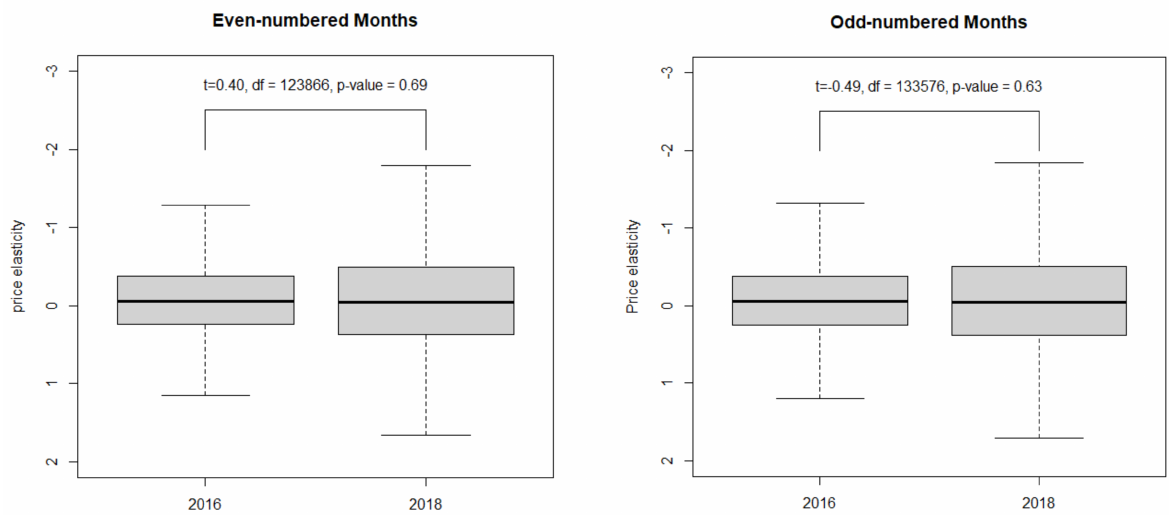
Figure 5. Comparison of price elasticity between the first year (2016) and the third year (2018) after the revision. Note: t in the figure shows the